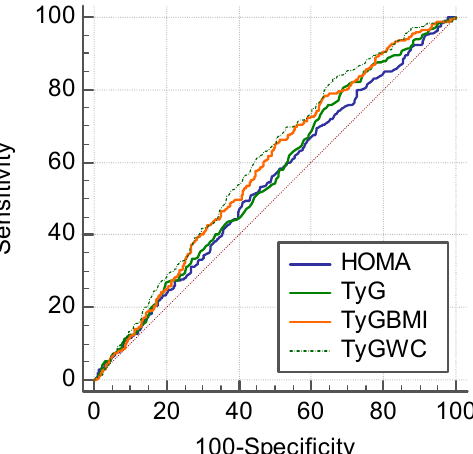
Figure 5. Receiver operating characteristic (ROC) curve of metabolic parameters for the CAC progression in the final cohort including non-progressors and progressors ( n = 1145). Table 3. Areas under the receiver operating characteristic curves of each parameter for CAC pro- gression in the final cohort including non-progressors and progressors ( n = 1145). Parameter AUC Standard Error HOMA-IR 1.000 The difference of prediction performance between the parameters were presented in the ROC curve (AUC) between the models. * Comparisons were adjusted for multiple comparisons using Bonferroni correction. AUC = area under receiver operating characteristic (ROC) curves; CI = con- fidence interval. 4. Discussion In the present longitudinal study using a large health-screening cohort, we observed that individuals with high TyG-related indices are more likely to experience CAC pro- gression. Among these indices, TyG-WC showed the strongest association with CAC pro- gression, a marker that predicts coronary artery disease and patient prognosis. In partic- ular, our analyses revealed that TyG-WC was positively associated with CAC score pro- gression, independently of conventional cardiovascular risk factors. Participants with TyG-WC in the highest quartile were 1.66 times more likely to suffer from CAC progres- sion after adjustment for confounding variables compared with those with TyG-WC in the lowest quartile. According to ROC analysis, TyG-WC was the most reliable predictor of CAC progression among the parameters we evaluated. This positive association be- tween TyG-WC and CAC progression implies adverse cardiovascular outcomes in indi- viduals with a high TyG-WC, considering the predictive value of CAC progression for future adverse cardiovascular outcomes.